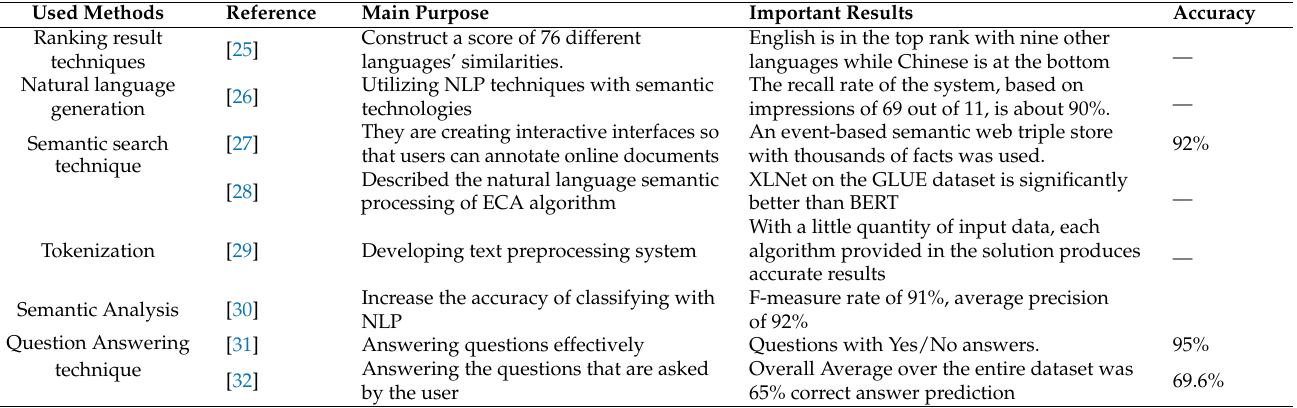
Table 3. Comparison among the different semantic search techniques or